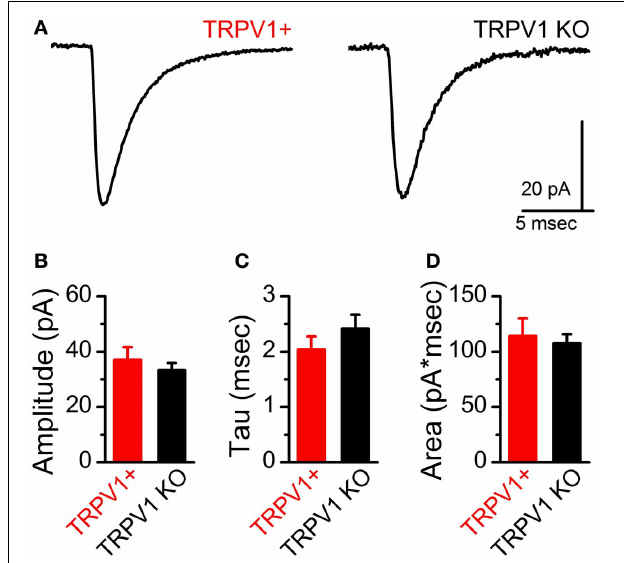
FIGURE 6 | No difference in spontaneous EPSC waveforms between control and TRPV KO ST afferents. (A) Representative average sEPSCs from control and TRPV1 KO afferents. Waveforms are the average of 100 events. Statistical comparison of sEPSC amplitude (B) and decay kinetics ( Tau, C) and integrated current ( Area, D) were not significantly different between TRPV1 + and TRPV1 KO afferents ( P = 0 . 46, 0.71, and 0.31 respectively, unpaired t